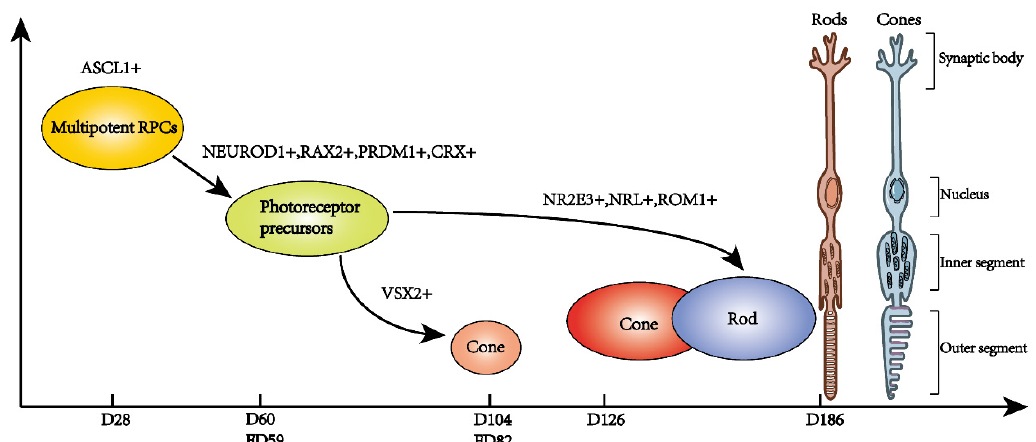
Figure 2. The developmental process of retinal photoreceptor in human fetal retina and retinal organoids. Multipotent RPCs of retinal organoid began to differentiate into neurons at approximately retinal organoid day 28 (D28) days when ASCL1 began to express. NEUROD1 + , RAX + , PRDM1 + , and CRX + RPCs were differentiated into photoreceptor precursors at about retinal organoid day 60 (D60) which was similar to fetal day 59 (FD59). VSX2 + photoreceptor precursors differentiate into cones at D104, which was similar to fetal day 59 (FD82). NR2E3 + , NRL + and ROM1 + photoreceptor precursors differentiate into rods at D186.